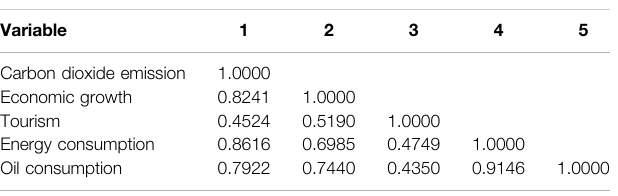
TABLE 3 | Correlation.